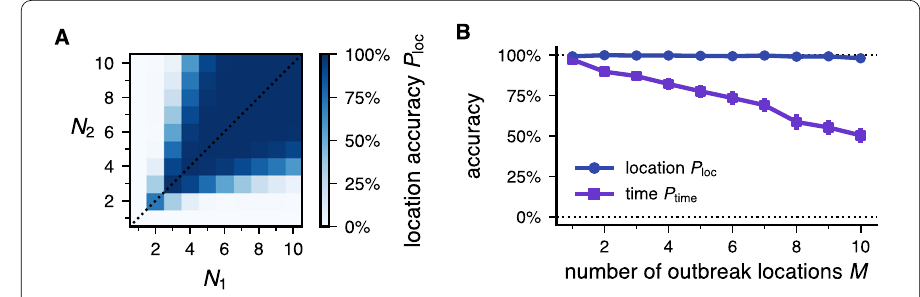
Figure 3 Accuracy of the inference method for multiple outbreak origins. A For multiple origins (here M = 2), the location accuracy P loc increases with sample sizes N 1 and N 2 , especially if a similar number of samples is available for all origins ( N 1 ≈ N 2 , dotted line). However, if more trajectories stem from one origin instead of the other ( N 1 (cid:10) = N 2 , off-diagonal entries), the accuracy actually decreases as the overrepresented location masks the other locations. B The accuracy of the location prediction is approximately independent of the number of outbreak locations M , while the time accuracy decreases. Sample size is N i = 4 for all origins i . Results are shown for the dEPR